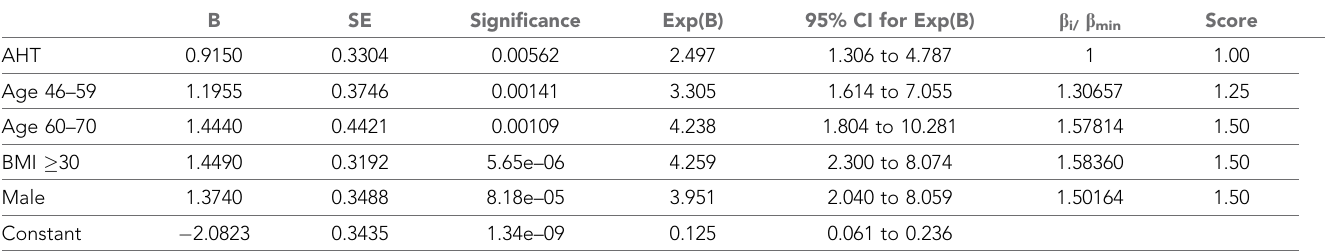
Table 4. Derivation sample. Final logistic regression and scores for the clinical prediction